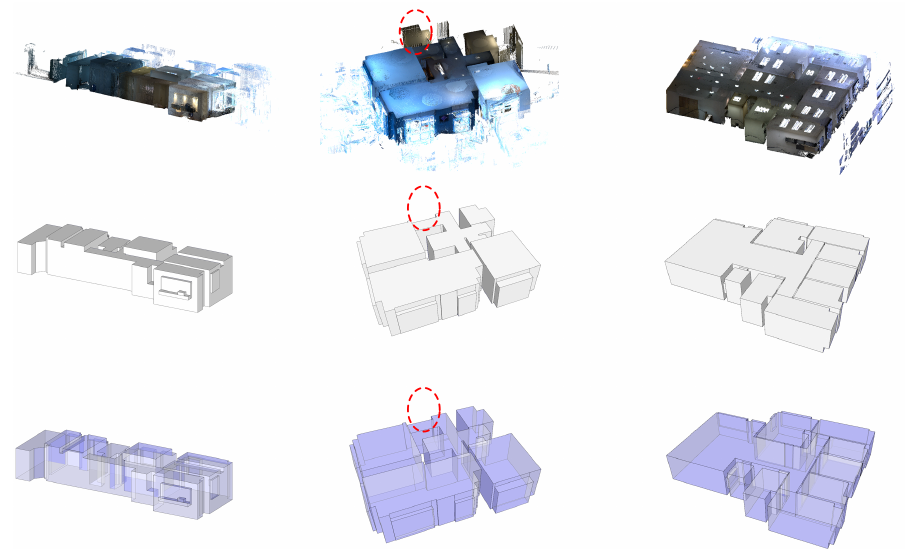
Figure 20. Modeling outputs of the proposed method. From top to bottom: The original point clouds, the reconstructed models with ceilings, and the transparent view of models. The red circles denote the missing room in the